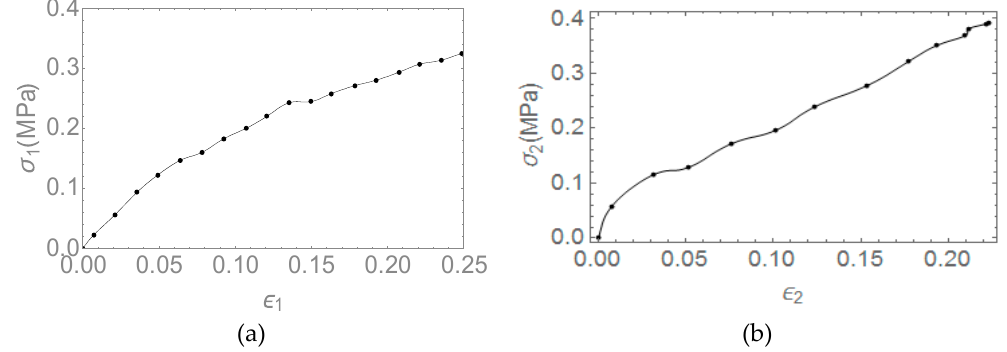
Figure 6. Stress strain curve of AFA100: ( a ) Direction x 1 , and ( b ) direction x 2.